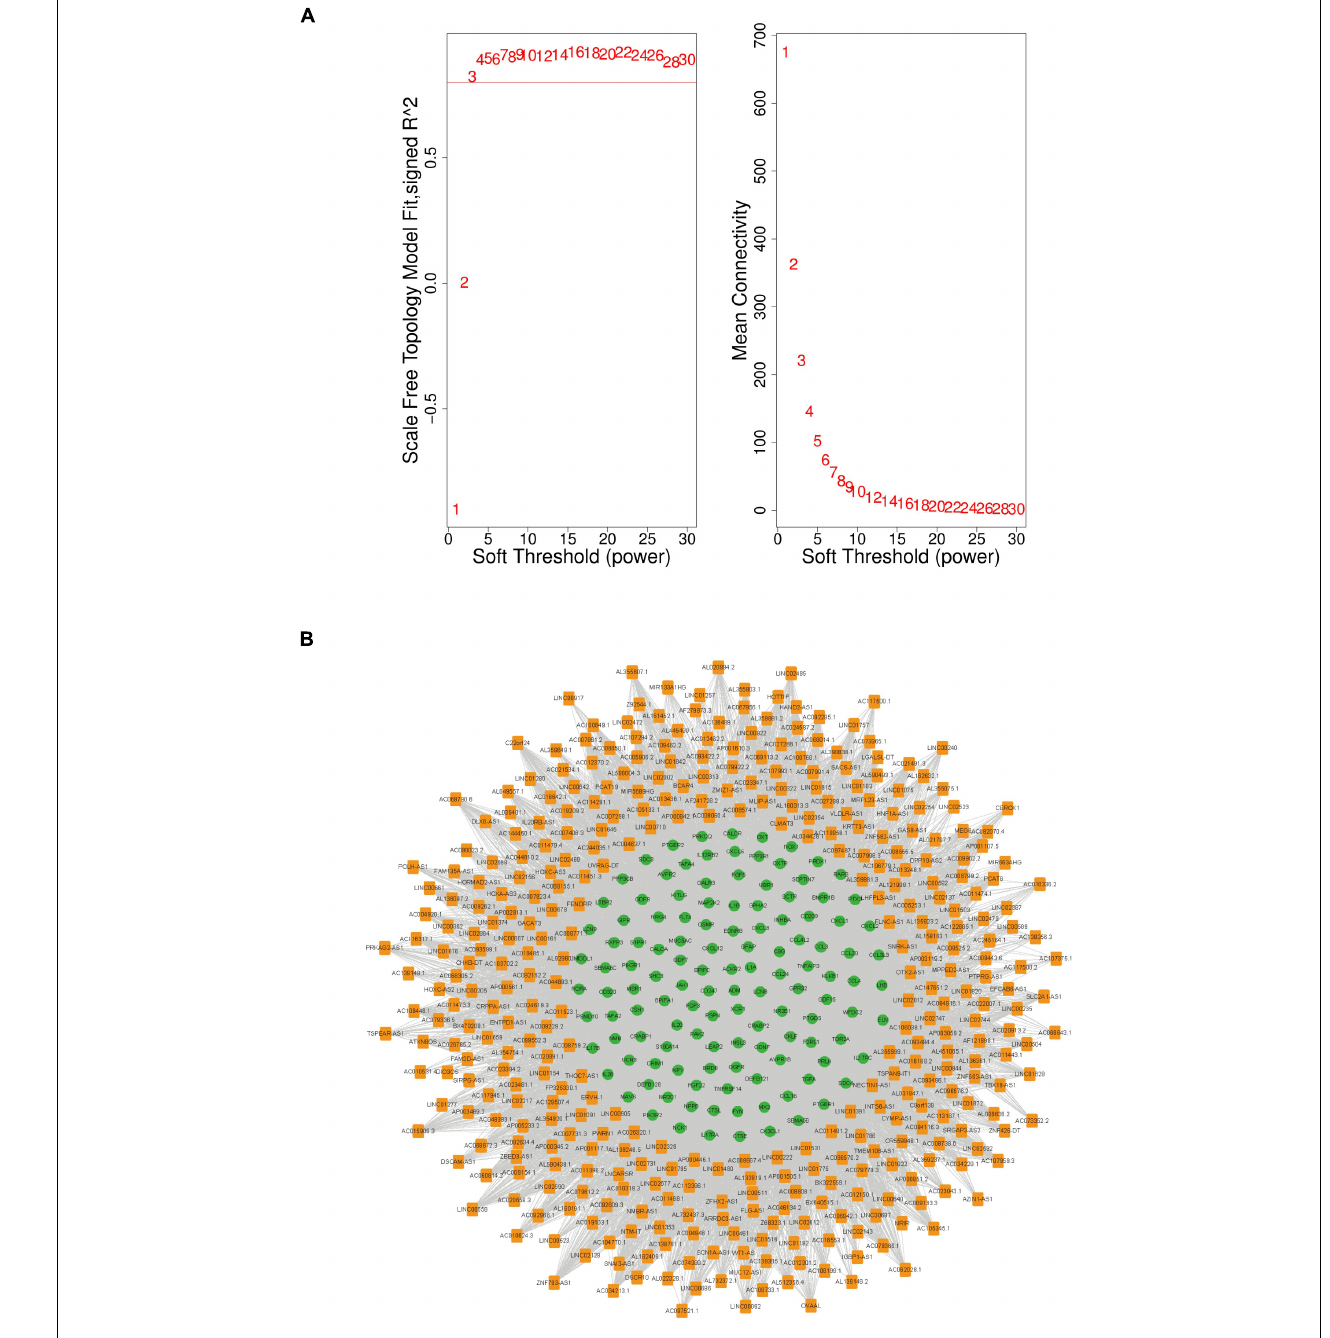
FIGURE 4 | The immune-related lncRNA-mRNA weighted gene co-expression network in CAD. (A) Selection of the soft threshold to analyze the network topology; if a soft-threshold power of 3 is selected, the appropriate scale-free fit index can be attained. (B) The immune-related lncRNA-mRNA weighted co-expression network including 496 network nodes (377 lncRNAs and 119 mRNAs). Orange nodes that denote lncRNAs and green nodes that denote mRNAs. CAD, coronary artery disease; lncRNA, long non-coding